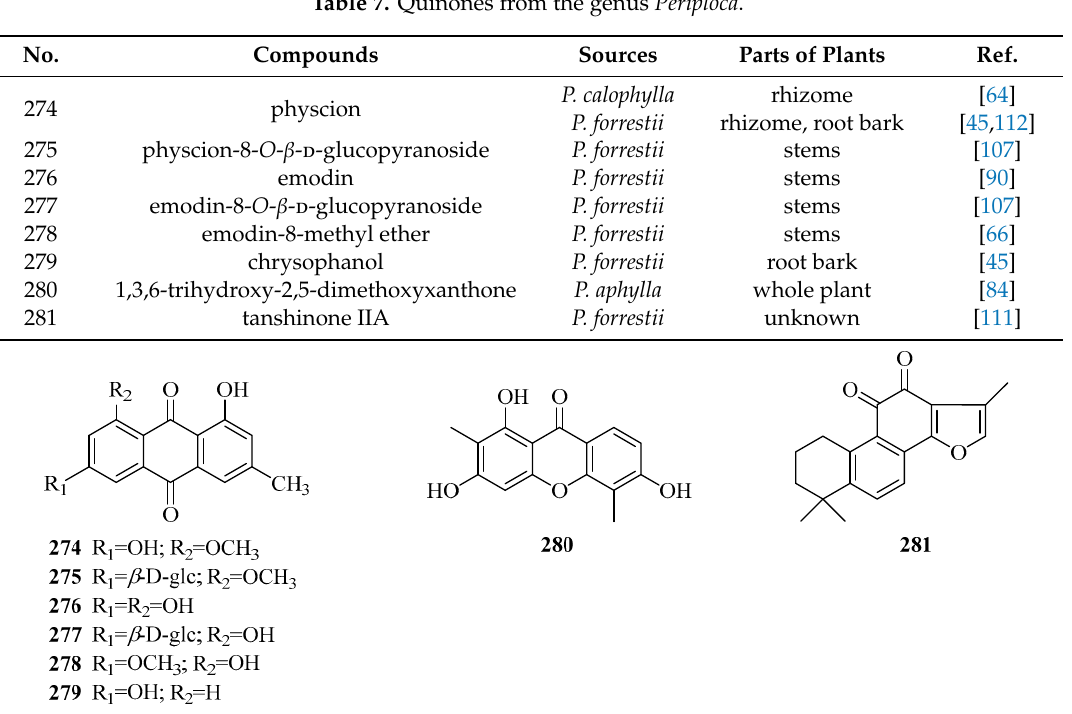
Figure 9. Quinones from the genus Periploca .